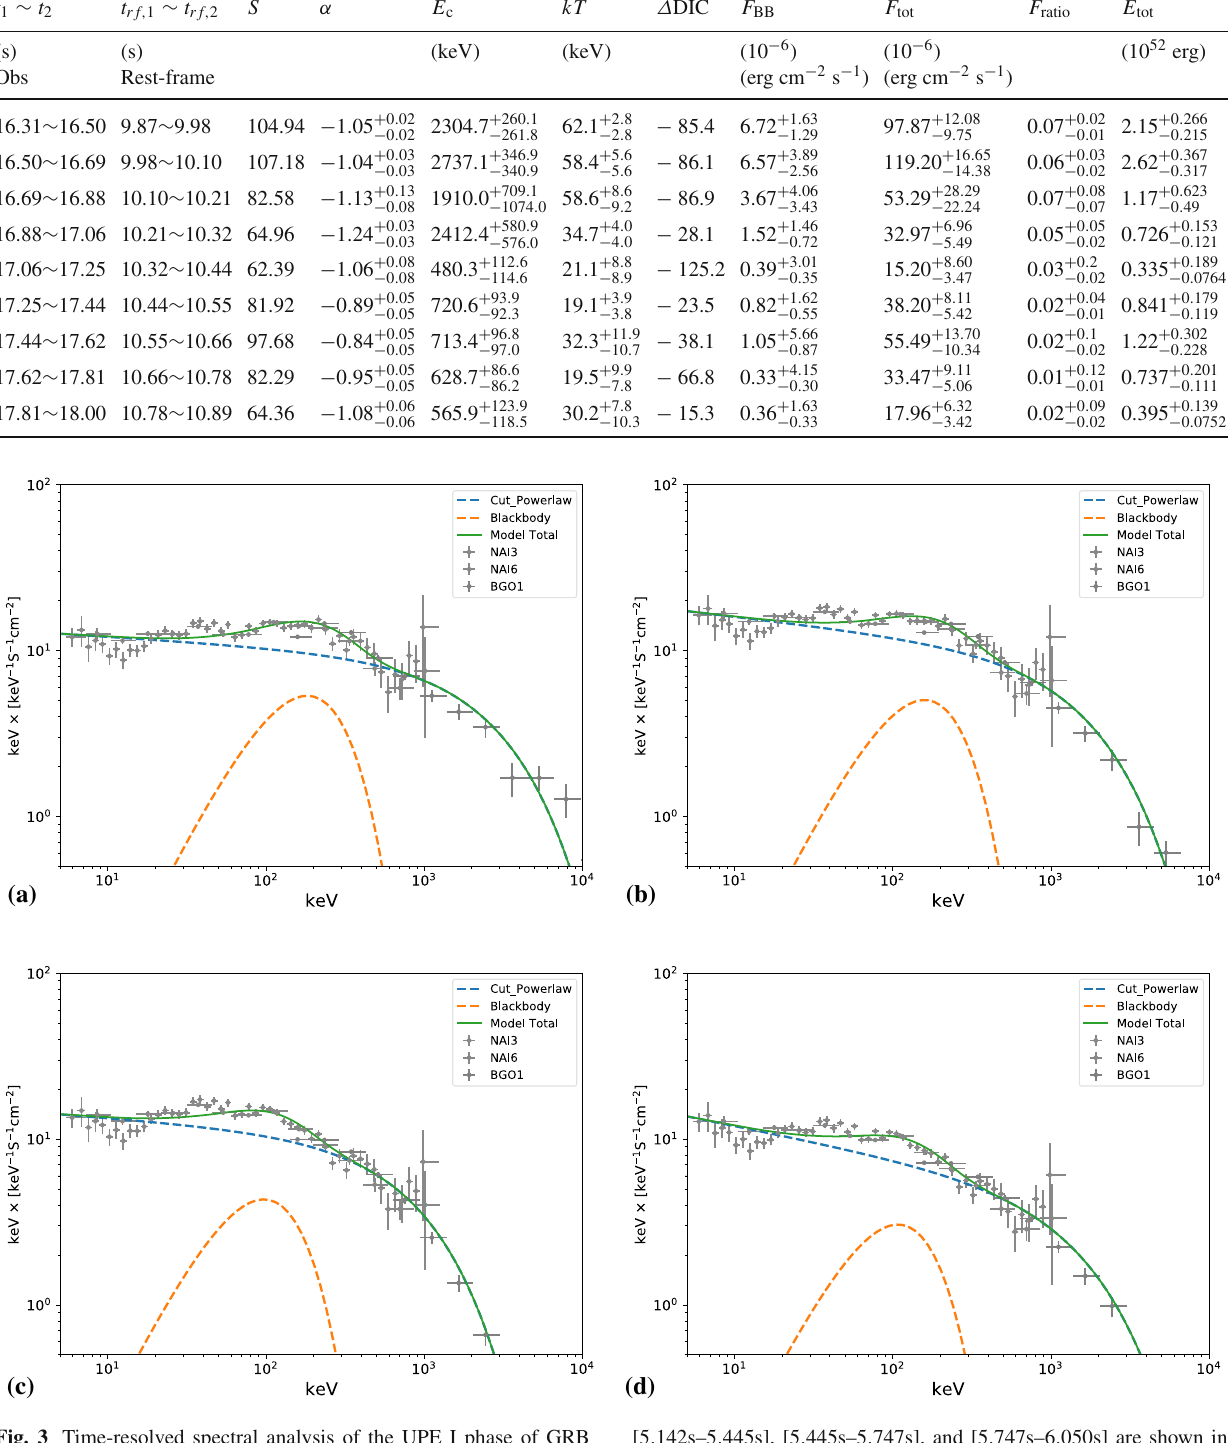
[5 . 142s–5 . 445s], [5 . 445s–5 . 747s], and [5 . 747s–6 . 050s] are shown in panels a – c , respectively. The CPL + BB is confirmed to be the best fit for each time interval. The best fit parameters are listed in Table